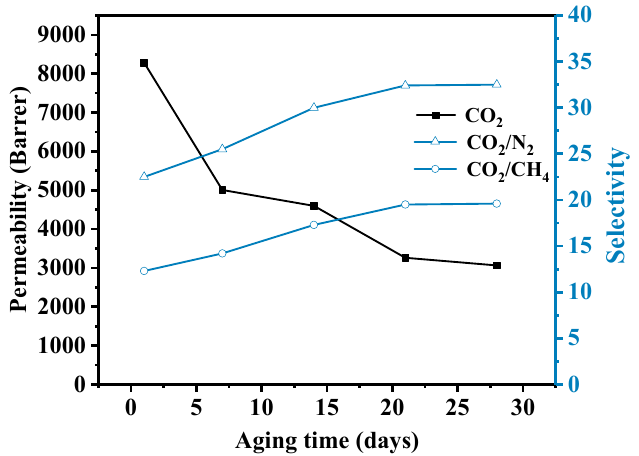
Figure 7. The separation performance of UiO-66-NH 2 @IL/PIM-1 MMM after aging tracked over 28 days.